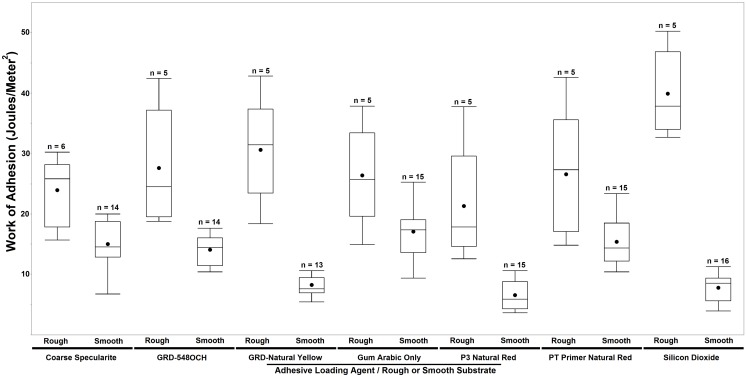
Box and whisker plots of Phase 1 results by adhesive loading agent and substrate condition classes.The horizontal line in each box indicates the median adhesive fracture energy for that class and the solid dot indicates the mean adhesive fracture energy for that class.